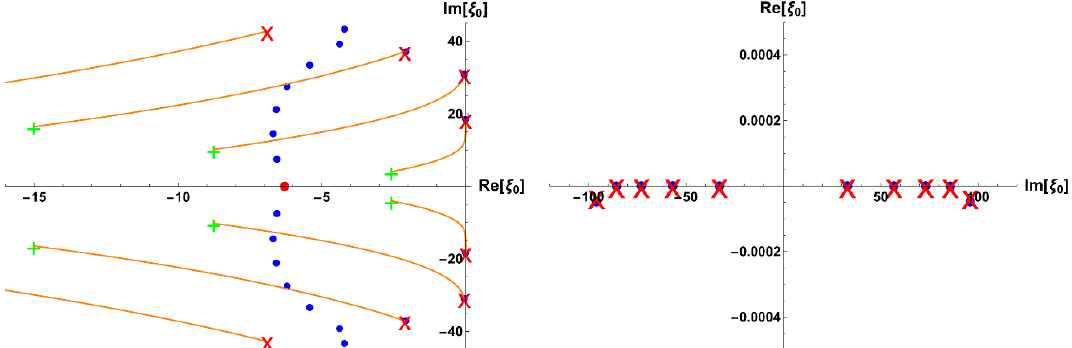
Figure 16 . Borel plane singularities (solid circles) and the QNM frequencies (crosses) at s = 100 (left panel) and s = 1000 (right panel). Red solid circles characterize the location of the wall-of- poles. Green crosses represent QNM frequencies at s = 0, red crosses correspond QNM frequencies at s = 100 (left panel) and s = 1000 (right panel). Orange lines represent the ‘(cid:13)ow’ of the QNM frequencies as s 2 [0 ;